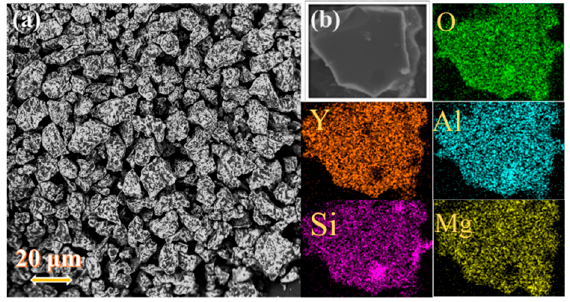
Figure 2. ( a ) The SEM image of YMASG:0.05Ce 3+ . ( b ) The EDS mapping of YMASG:0.05Ce 3+ .